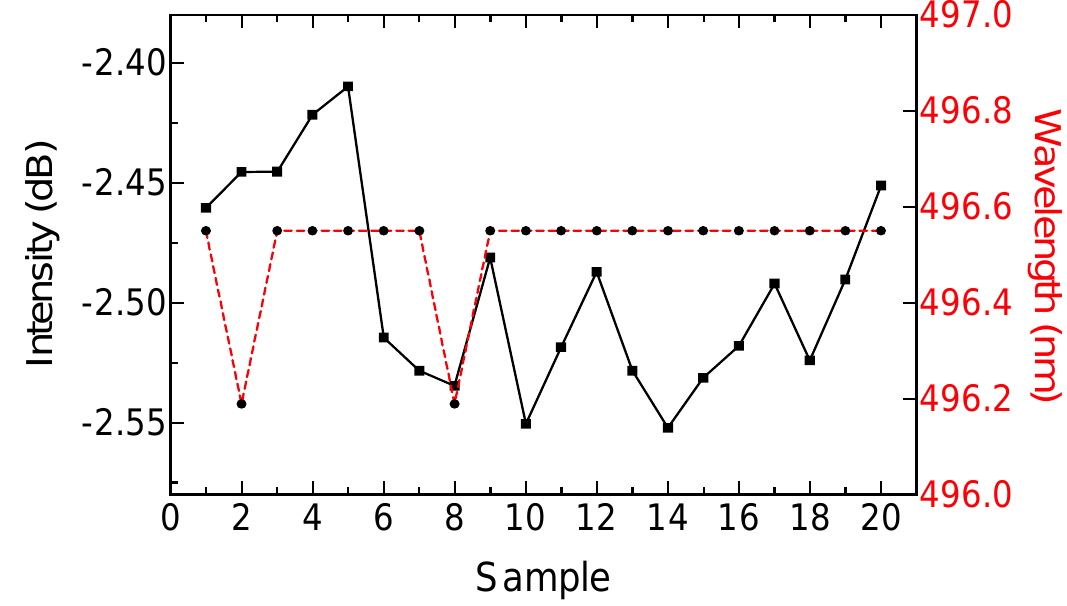
Figure 11. Comparison of intensity and wavelength displacement in the repeatability test.